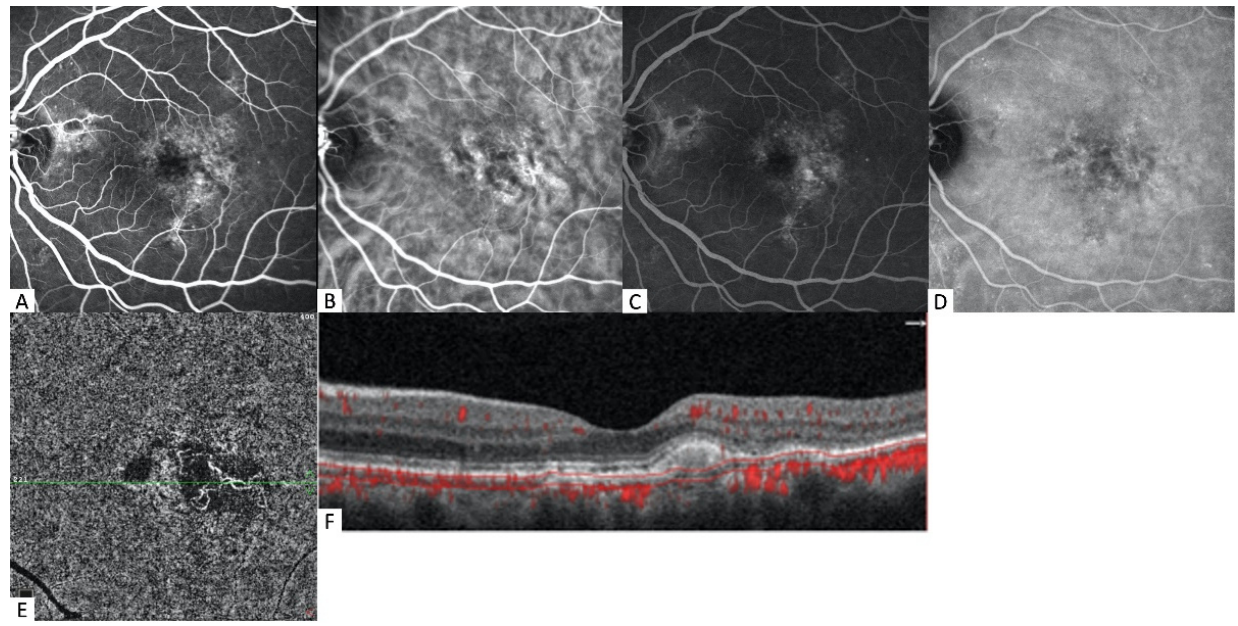
Figure 1. Multimodal imaging of the left eye of a 61-year-old female patient. ( A , C ) Marked and stippled hyperfluorescent areas of leakage are seen in the early and late phases of FA. ( B ) In the early frame of ICGA, a prominent hypercyanescent neovascular network is detected. ( D ) This network is clearly visible in the late phases of ICGA. ( E ) The choriocapillaris slab of OCTA confirmed the presence of a tangled fibrovascular network with peripheral anastomosis. ( F ) Corresponding B-scan with flow overlay shows a perifoveal flat irregular PED overlying flow signal, except in the area of the hyperreflective subretinal content.